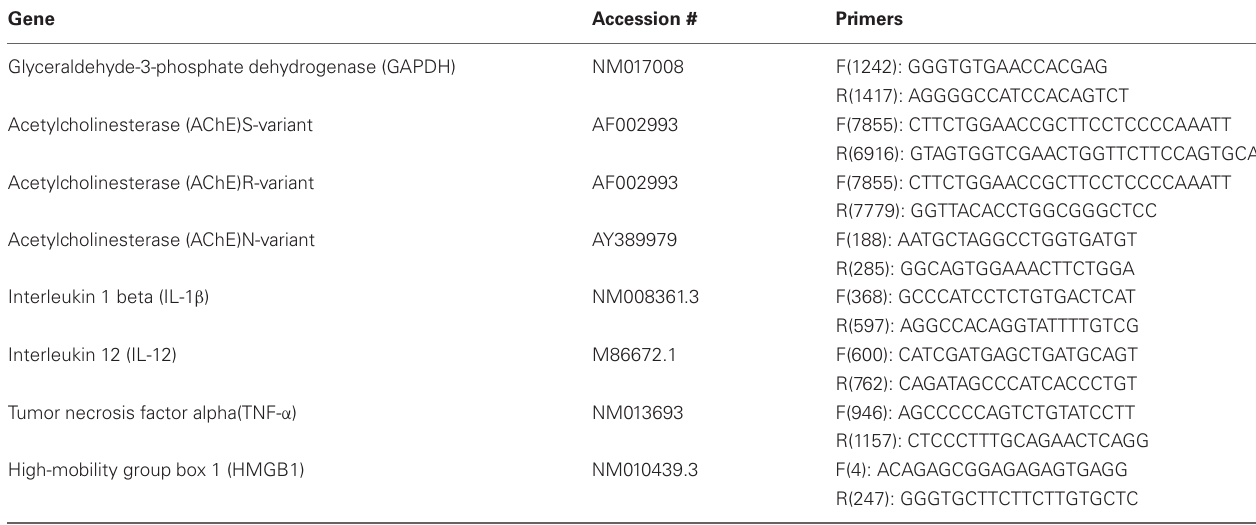
Table 1 | Primer pairs.